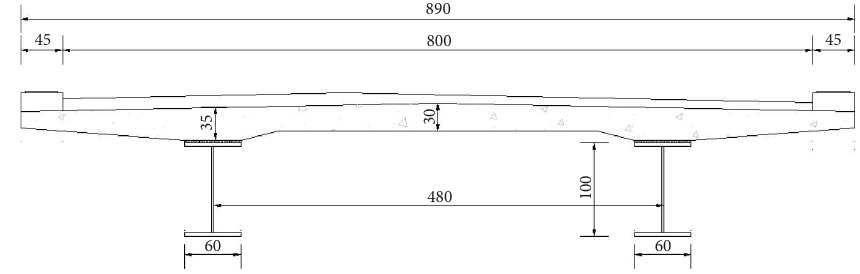
Figure 2: Te key section of the girder